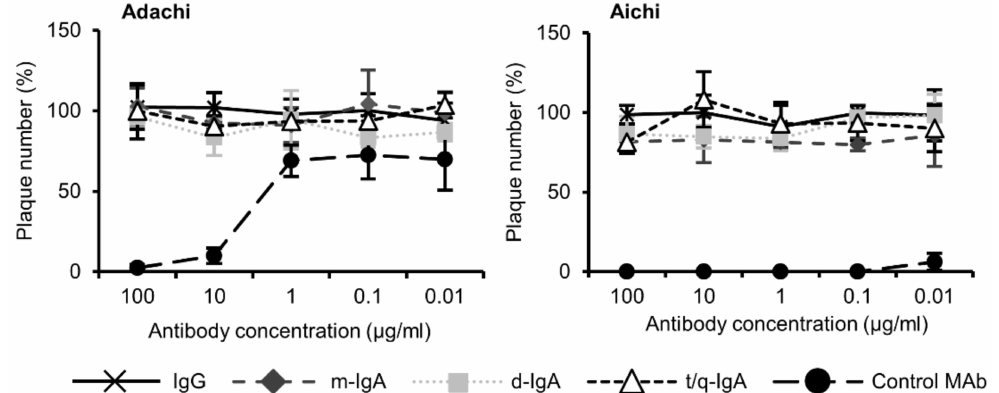
Figure 3. Neutralization tests of ch-rM2ss23 antibodies. Serial dilutions of ch-rM2ss23 IgG, m-IgA, d-IgA, and t / q-IgA and positive control neutralizing MAb (0.01–100 µ g / mL) were mixed with each IAV strain, followed by plaque assays. Means and standard deviations of plaque numbers were calculated from three individual experiments. Relative plaque numbers to each control sample (i.e., cells incubated without MAbs) are